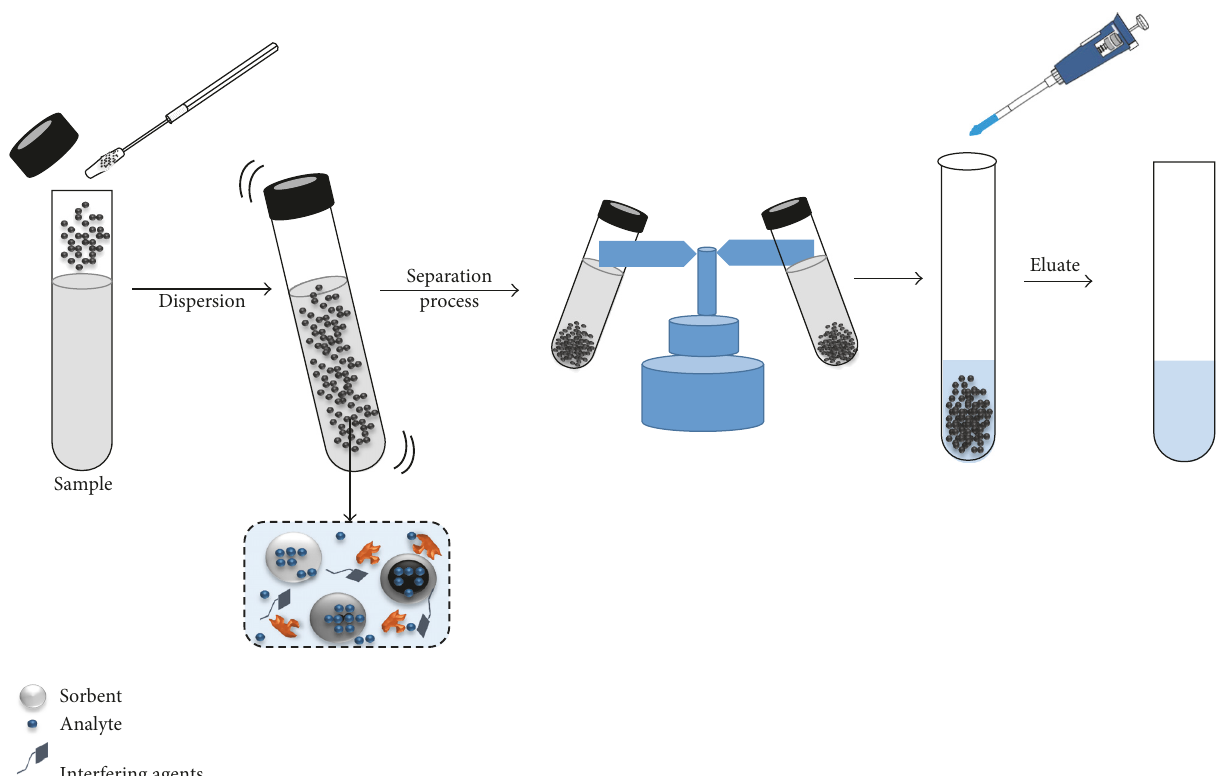
Figure 1: Scheme of dispersion methodology by dispersive solid phase